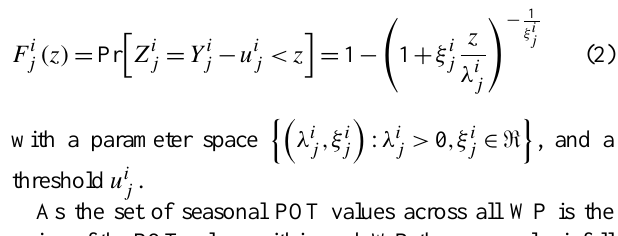
Fig. 4 is a box plot of annual daily rainfall maxima for each month at Lyon and St Etienne en D´evoluy. The sea- sonal pattern is rather common for daily rainfall in southern France, with the highest quantiles (“season-at-risk”) occur- ring between September and November (as shown for St Eti- enne en D´evoluy). For Lyon, this “season-at-risk” is more likely June to